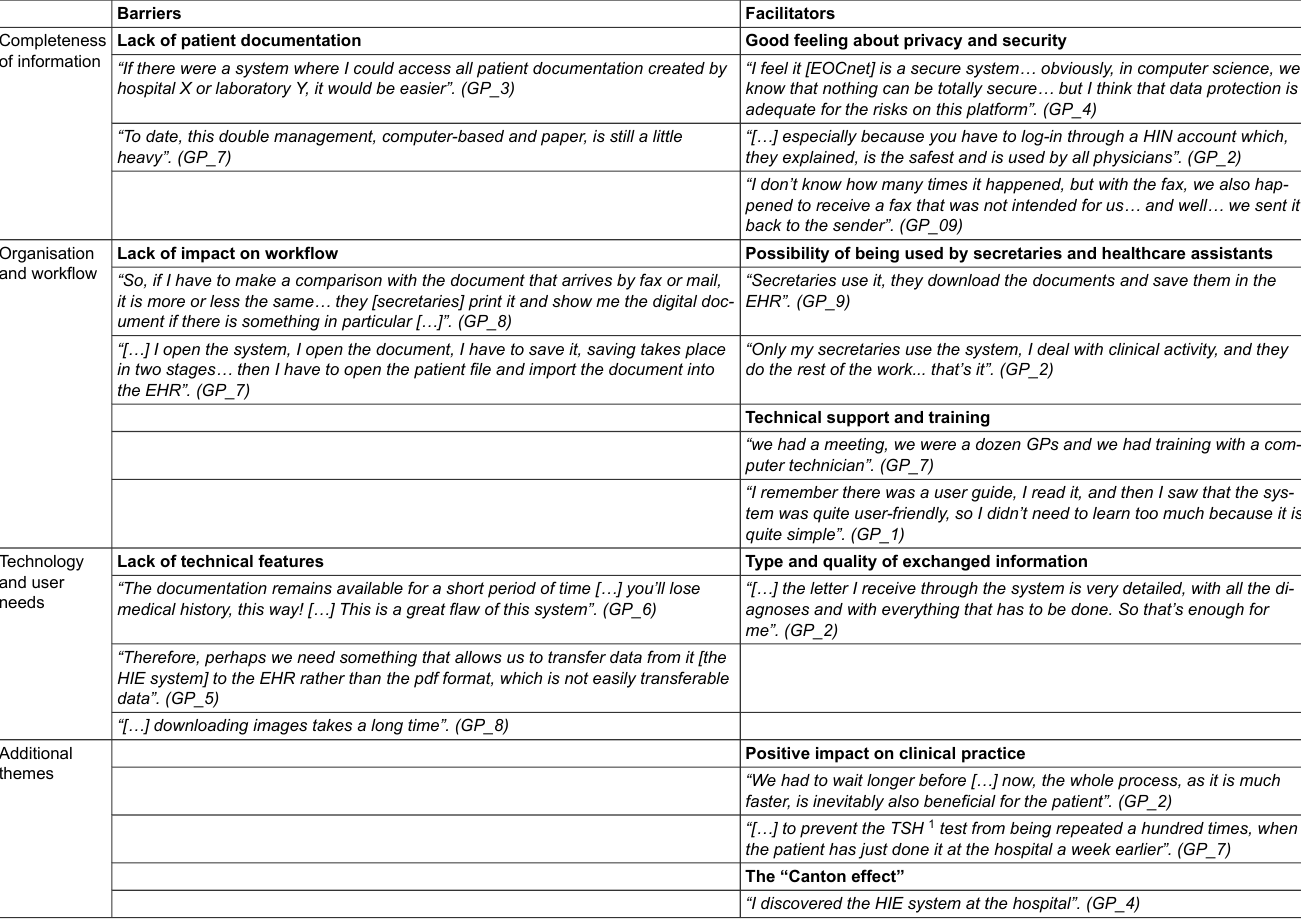
Table 3: Themes and related